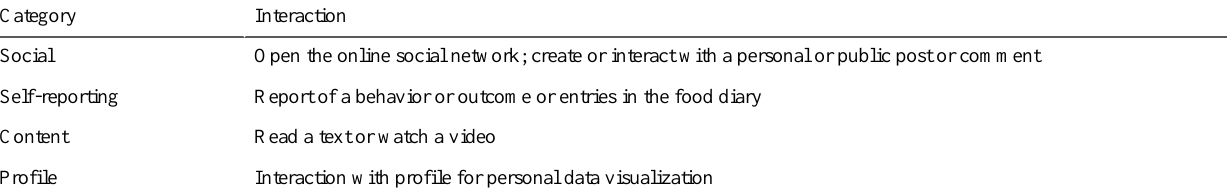
Table 1. Interactions participants could have with the platform in the two intervention groups. InteractionCategory Open the online social network; create or interact with a personal or public post or commentSocial Report of a behavior or outcome or entries in the food diarySelf-reporting Read a text or watch a